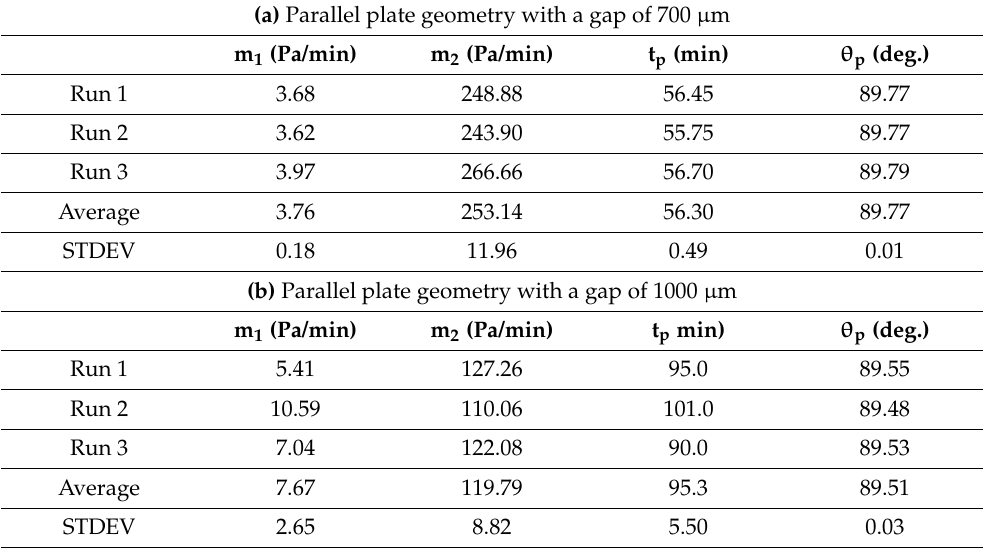
Table 2. Results from static yield stress tests with: (i) parallel plate geometry and (ii) vane rotor and cylinder cup